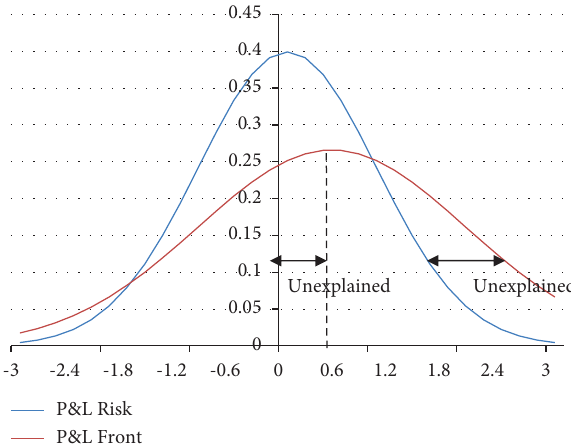
Figure 2: Te unexplained mean and